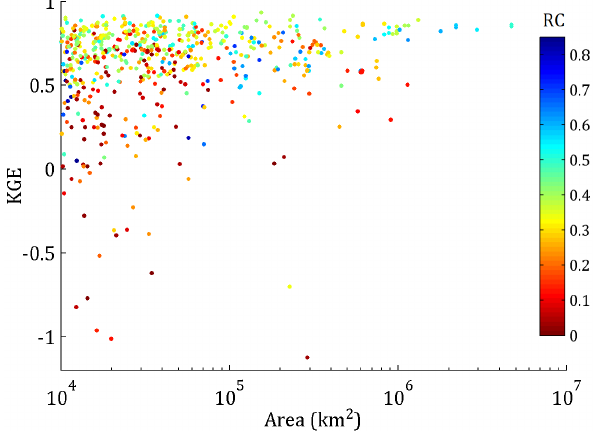
Figure 3. MGB model performance (KGE) versus RC and drainage area over South